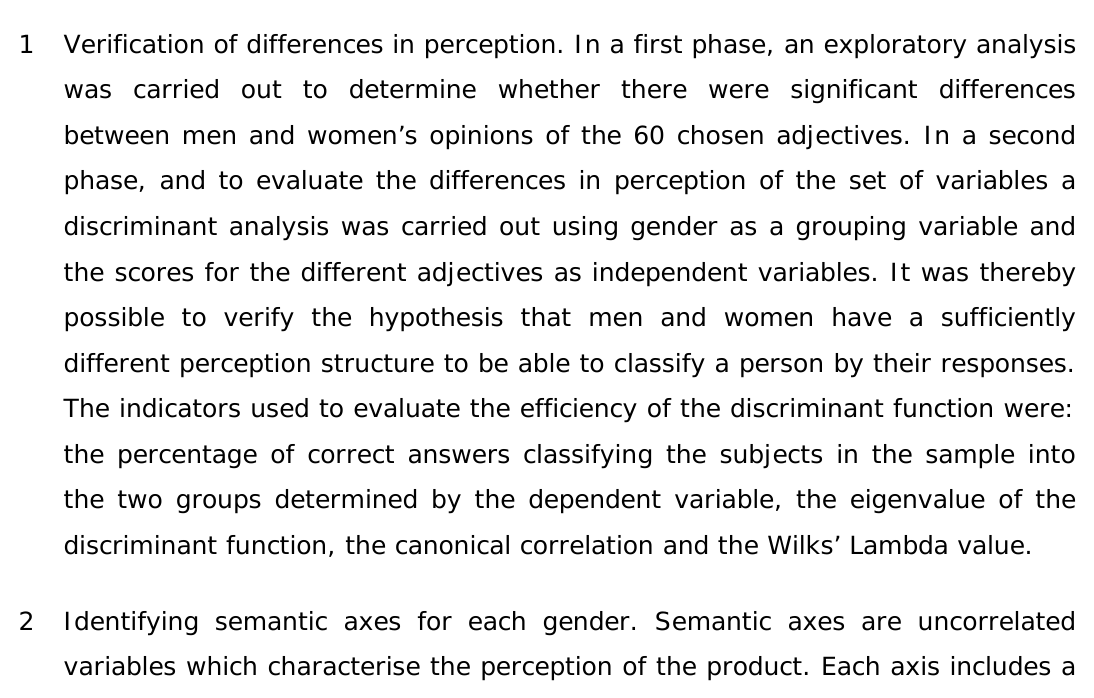
Identifying semantic axes for each gender. Semantic axes are uncorrelated variables which characterise the perception of the product. Each axis includes a combination of adjectives of the original set that present significant correlations in the customers’ responses. They therefore group adjectives that usually have similar evaluations and which are supposed to represent common concepts implicity used by men and women to assess properties on sale. Factor analysis was used to identify and extract the semantic axis (Basilevsky, 1994; Flury, 1988). We selected only principal components with eigenvalues greater than one, and a further Varimax rotation was made to obtain the semantic axes factors. Ranking semantic axes for each gender. The attributes associated to the semantic axes represent common concepts which explain the perceived differences between housing from the customer point of view. Nevertheless, the influence of each axis on the global evaluation may be very different. This relation can be quantified by means of a statistical relationship, for example a correlation coefficient. We have used the nonparametric Spearman correlation coefficient between the factor scores and the overall opinion to measure this influence, and the axes were ranked according to this criterion. Comparative analysis: semantic profiles for each gender. The semantic profile of a specific property on sale is a diagram that represents the scores obtained in each semantic axis. Since factor analysis provides scores that are centered in relation to the average of the sample analysed, the semantic profile allows